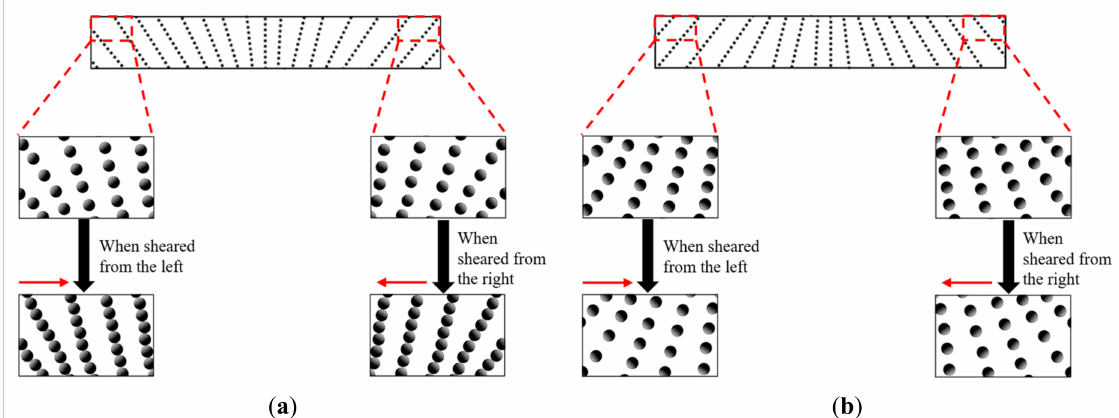
Figure 13. Schematic diagram of fountain-like MREs respective to the applied shear stress: ( a ) Fountain-like Side-1, ( b ) Fountain-like Side-2. The magnified square area represents the par- ticle chains at edges of the